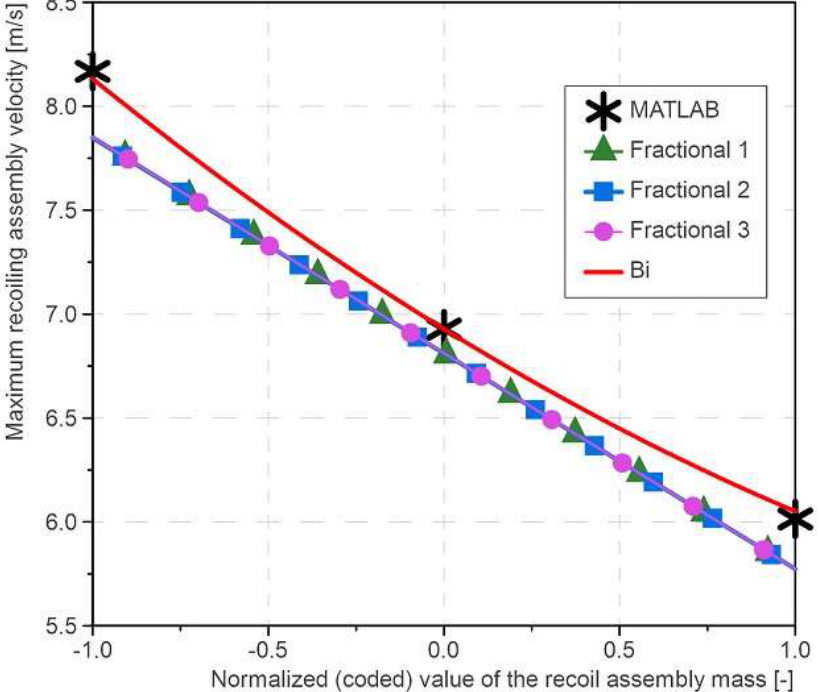
Figure 4. Diagram of the maximum recoiling assembly velocity as a function of the normalized (coded) value of the recoiling assembly mass.